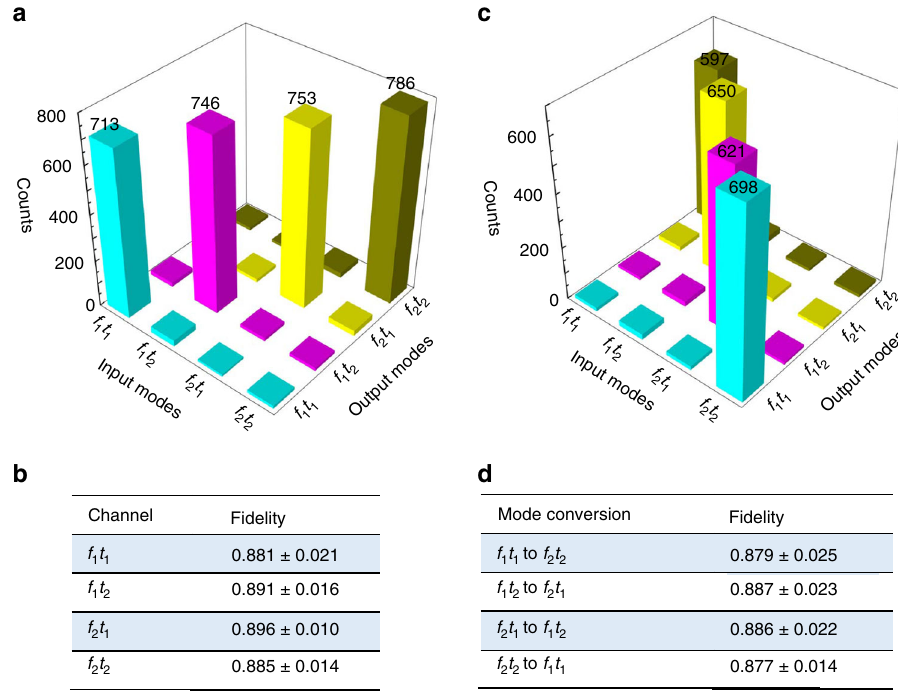
Fig. 4 Multiplexed storage and quantum mode conversion for spatial encoded qutrit state using four temporal and spectral channels. a The multiplexed storage for spatial-qutrit state of | ψ 1 〉 in the temporal and spectral DOF. b Fidelities for the qutrit states after storage. c The performance of the QMC with an encoded state of | ψ 1 〉 . d Fidelities for the qutrit state after mode conversion. The error bars for the fi delities correspond to one standard deviation caused by the statistical uncertainty of photon